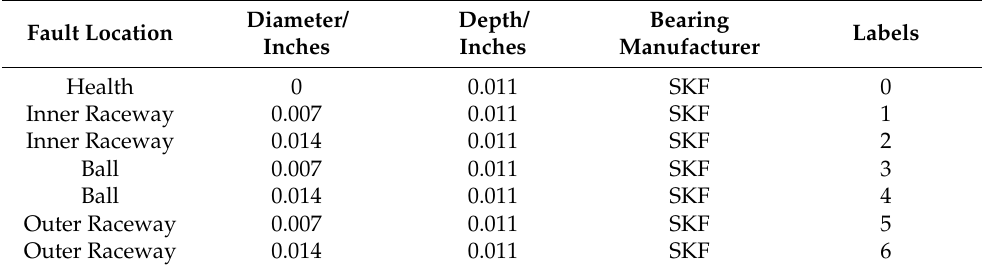
Table 11. Bearing fault description in CWRU data set.